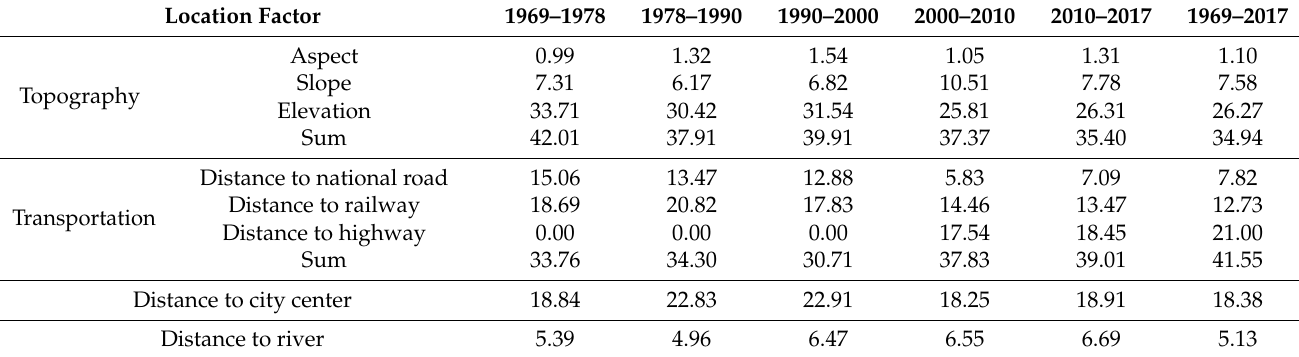
Table 4. The importance of location influence factors of urban expansion of Xining City in different time